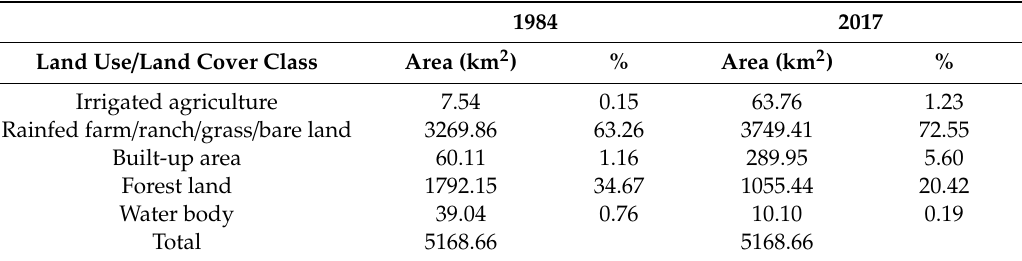
Figure 3. Land use / land cover map of Chongwe River catchment. Figure 3. Land use/land cover map of Chongwe River catchment . Table 3. Land use / land cover classification of Chongwe River Table 3. Land use/land cover classification of Chongwe River catchment .